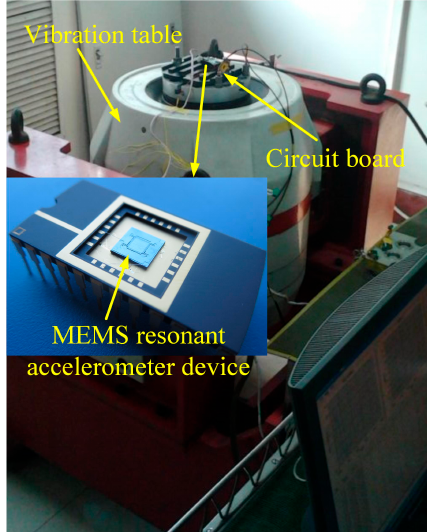
Figure 3. Test system of the MEMS resonant accelerometer sensor.